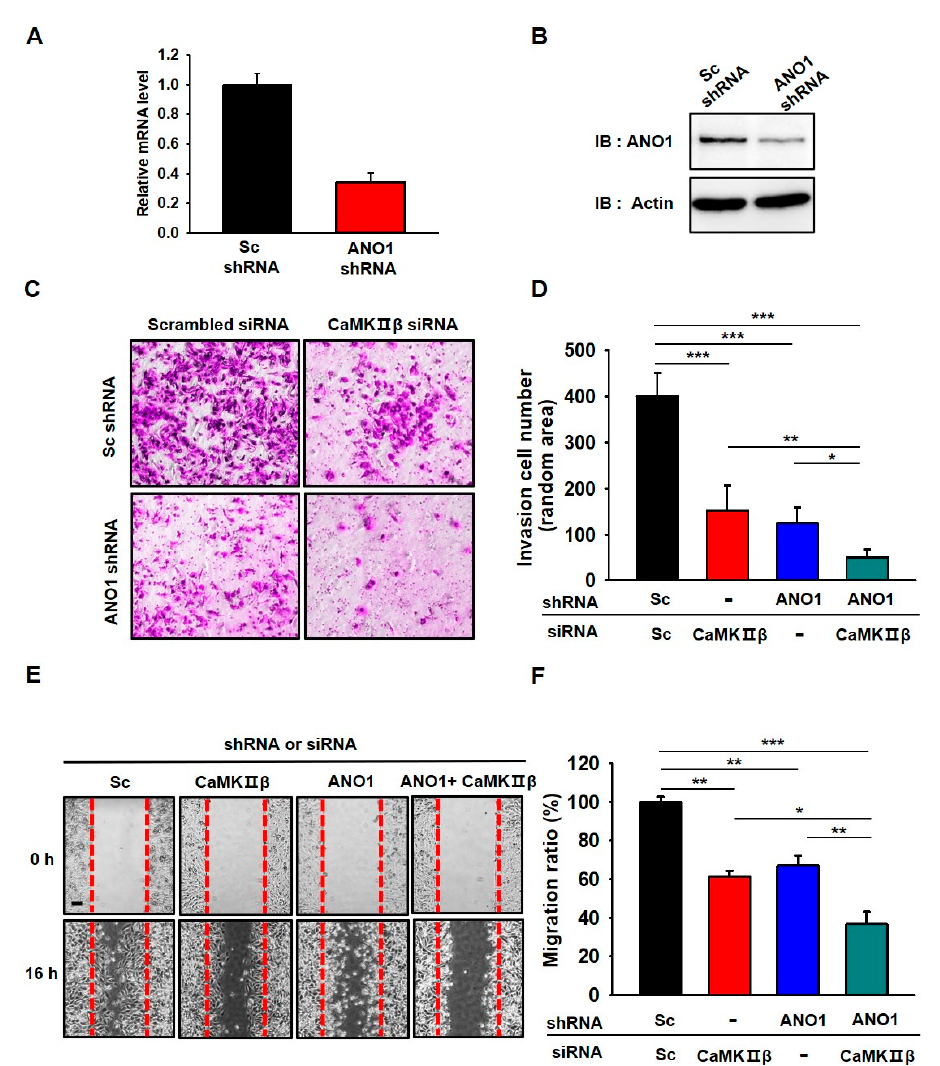
(Figure 5A,B). The mRNA and protein levels of endogenous ANO1 in U251 glioblastoma cells were clearly reduced by approximately 70% following treatment with ANO1 shRNA. Cells 2020 , 9 , x FOR PEER REVIEW